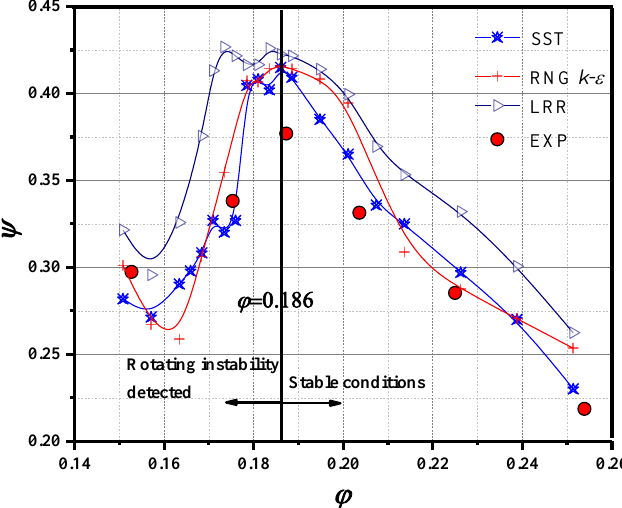
Figure 6. Performance curve simulated by different turbulence models comparing with experimental data.